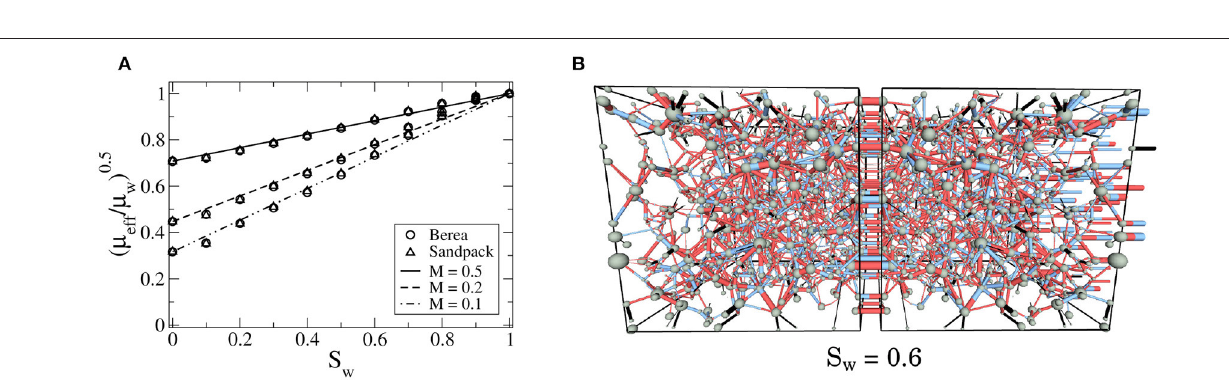
0.6 for 2D. (B) Typical =